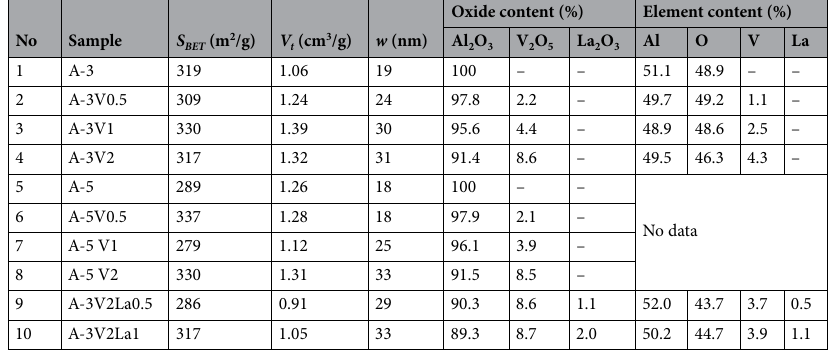
Table 2. Structural parameters and chemical composition of the analyzed